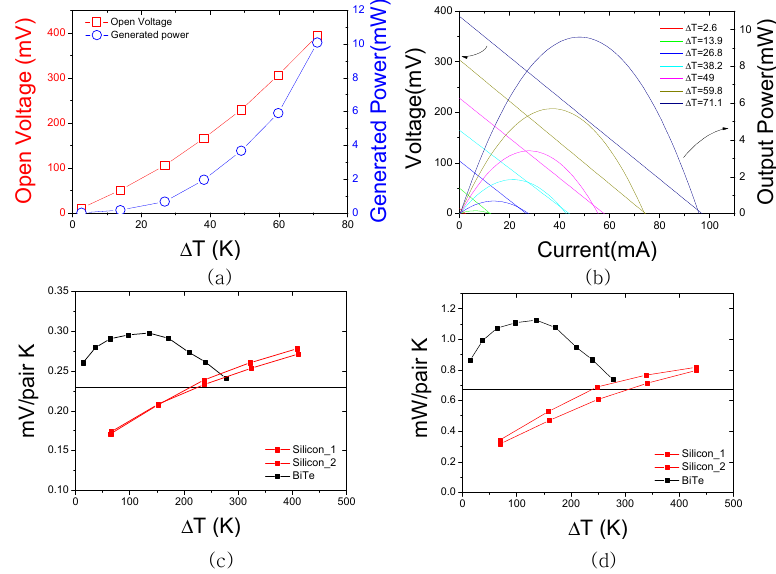
Figure 8. The performance of the fabricated thermoelectric module: ( a ) open circuit voltage and power of thermoelectric module according to the temperature, ( b ) output characteristics of thermoelectric module according to the temperature, ( c ) comparison of Voltage characteristics with commercial thermoelectric modules, ( d ) comparison of power characteristics with commercial thermoelectric modules.